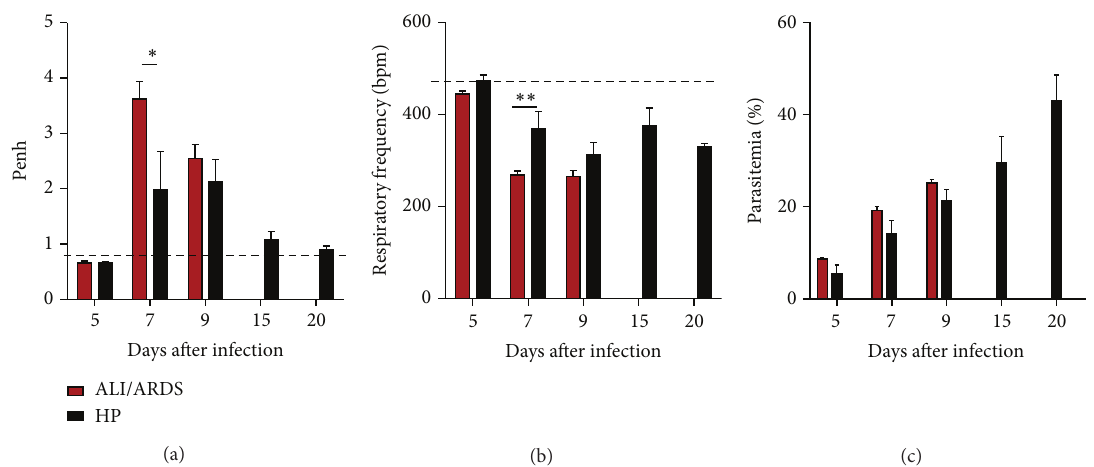
Figure 3: Breathing patterns and parasitemia from ALI/ARDS and HP mice over time. (a) and (b) Breathing patterns and (c) parasitemia from DBA/2 mice infected with P. berghei ANKA that developed ALI/ARDS and HP over time. (a) There was no evidence on the 5th and 9th DAI that the ALI/ARDS and HP mice had different breathing patterns. However, on the 7th DAI, there was evidence that the ALI/ARDS mice had a higher enhanced pause (Penh) (a) and a lower respiratory frequency (b) than the HP mice. Parasitemia increased over time in both groups (c). Results are representative from three independent experiments ( 𝑛 = 11 mice/experiment; ∗ 𝑃 ≤ 0.05 , two way ANOVA with Bonferroni post test). The dashed line represents the mean value of NI mice; NI: noninfected mice; ALI/ARDS: acute lung injury/acute respiratory distress syndrome; HP: hyperparasitemia.